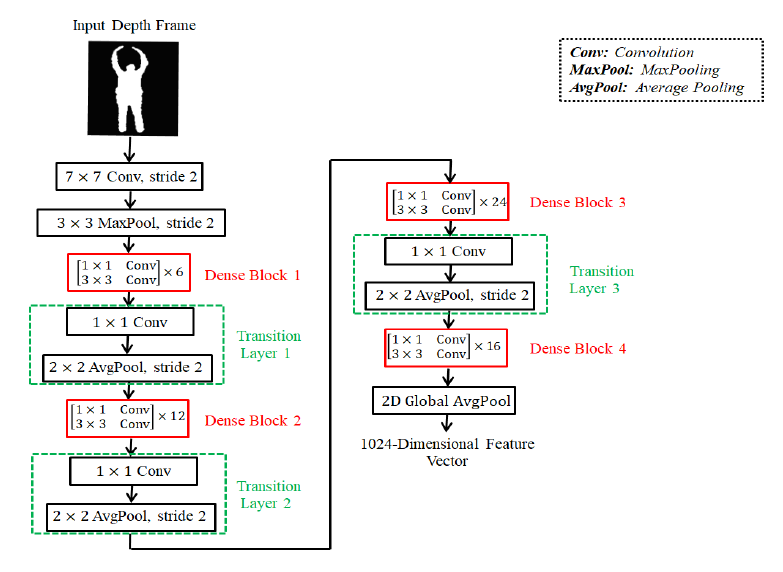
Figure 3. An example of feature extraction from depth frame using the DenseNet121